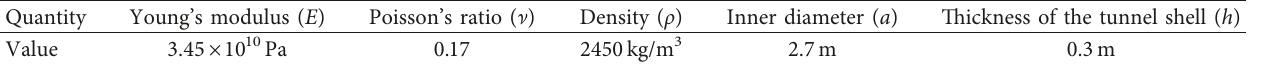
Table 5: Tunnel lining parameter values.